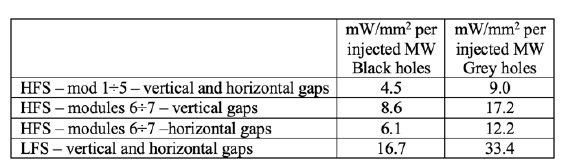
Table 4. power to be expected diffused behind the blanket